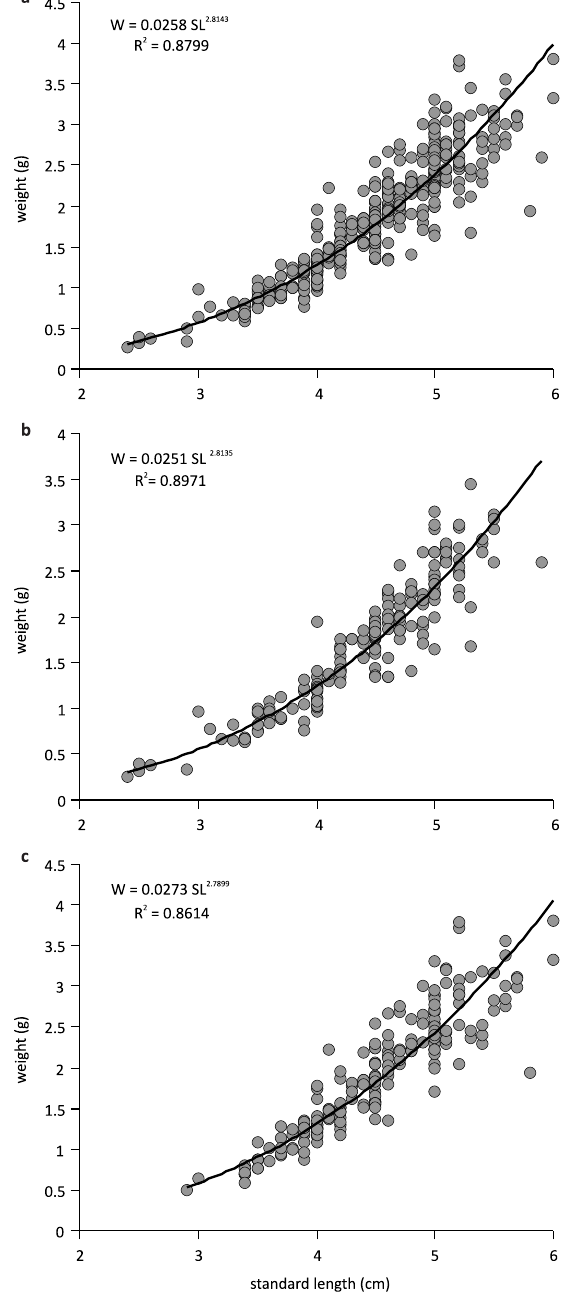
Figure 1. Length-weight relationships for (a) pooled data, (b) males and (c) females. All regressions are significant at P<0.001.